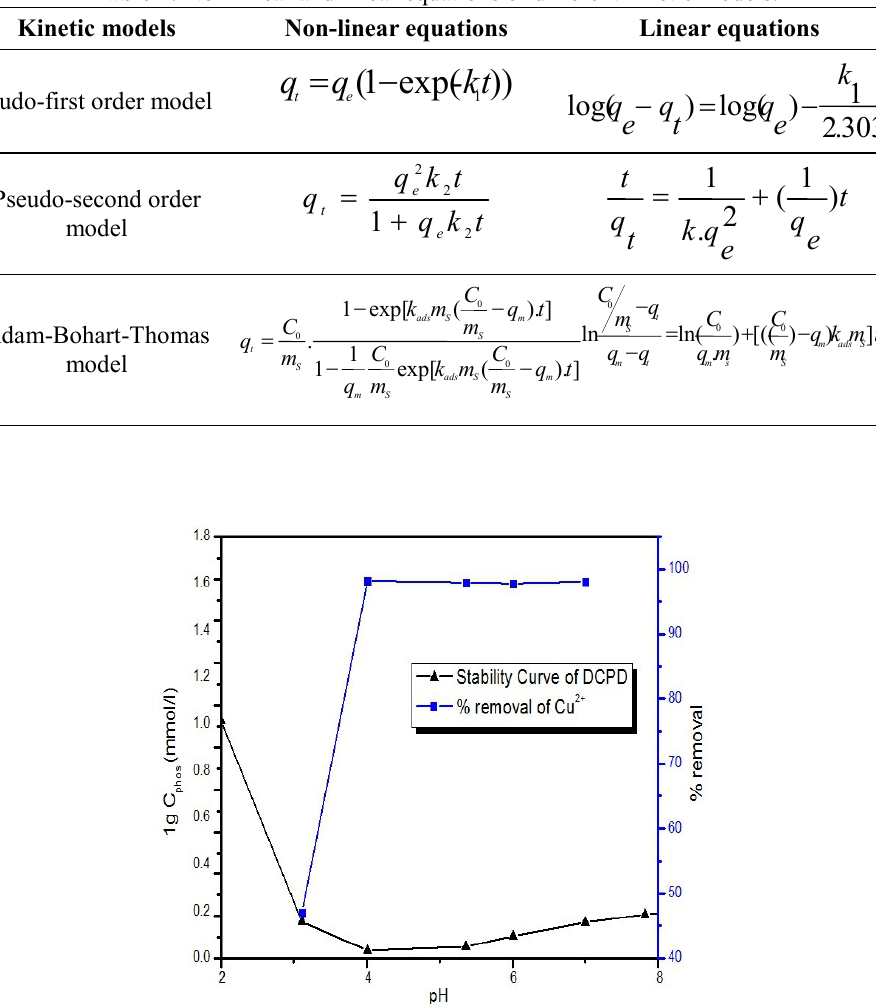
Figure 1. Influence of pH upon the removal of Cu(II) on Brushite (DCPD) C = 100 mg/L; V = 100 initial